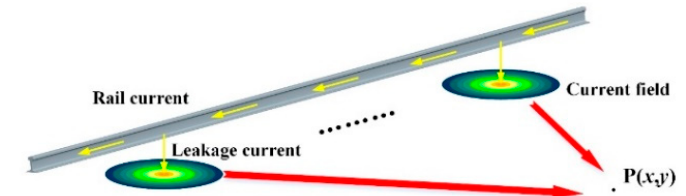
Figure 3. Effect of the stray current leakage on the potential near the running rail.